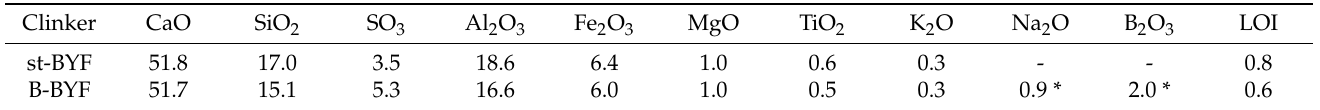
Table 1. Elemental compositions determined by XRF, expressed in weight percentage of oxides for both BYF clinkers, including loss on ignition